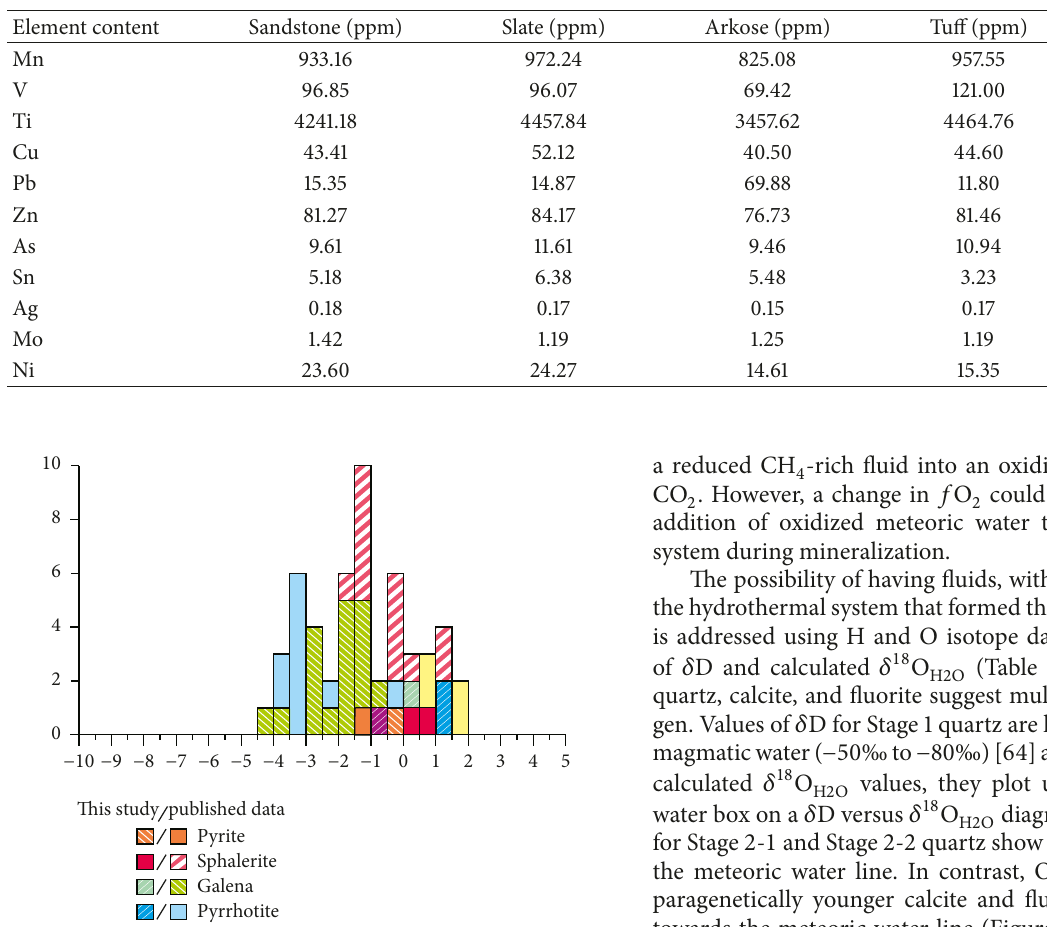
Table 4: Element abundance in lithologies of Permian strata, SGXR [43].